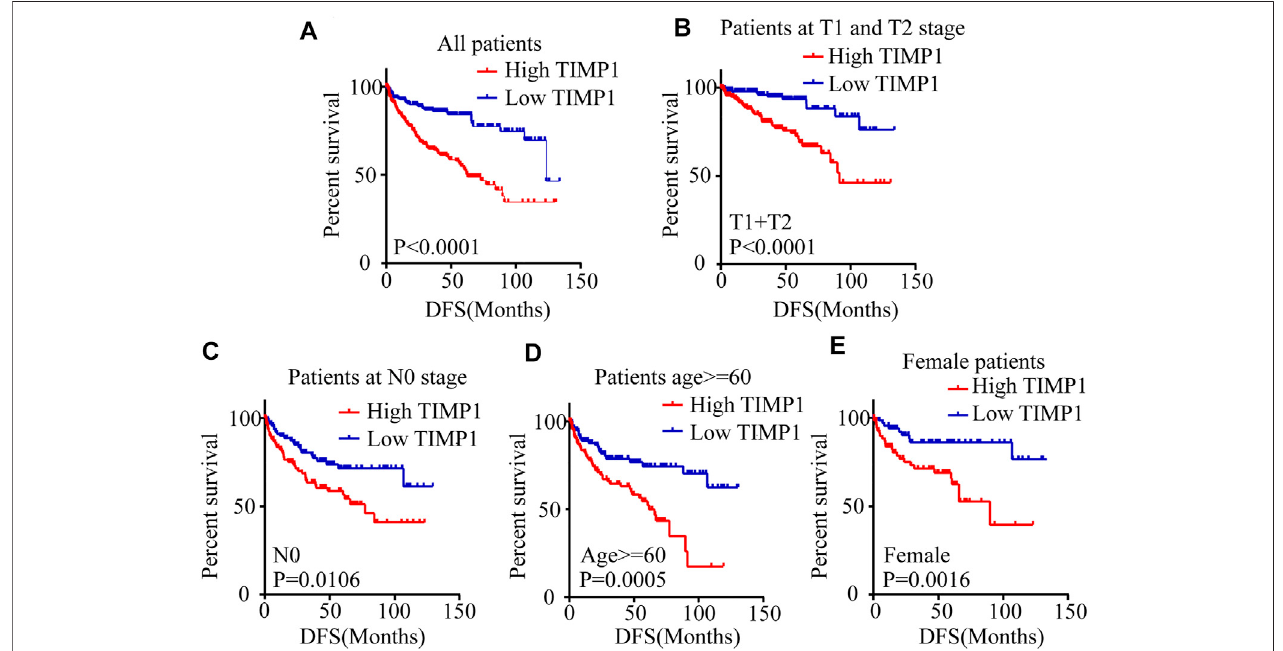
FIGURE 4 | High level of TIMP1 suggested poor DFS of patients with RCC. Kaplan-Meier curves for disease-free survival (DFS) were performed in patients with RCC. (A) HighlevelofTIMP1indicatedpoorDFS.Kaplan-MeiercurvesforDFSasdeterminedbydifferentclinicalparametersinRCC. (B) PatientsatT1andT2stage, (C) Patients at N0 stage, (D) Patients with age ≥ 60, (E) Female patients. TIMP1, Tissue inhibitor matrix metalloproteinase 1; RCC, renal cell carcinoma; TCGA, The Cancer Genome Atlas.